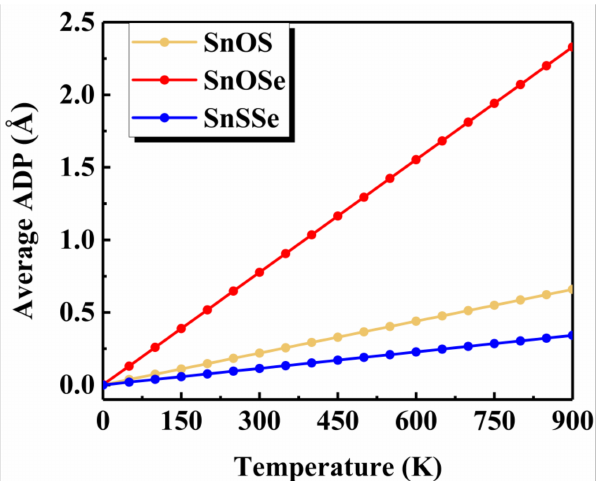
Figure 4. The average atomic displacement parameter (ADP) as a function of temperature for the three Janus